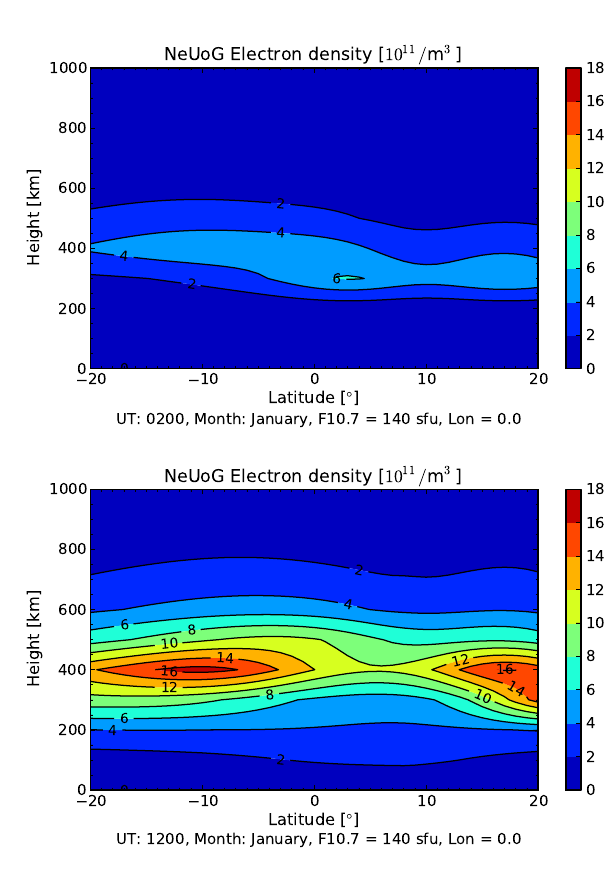
Fig. 2. Electron density distribution in January for F 10 . 7 = 140sfu as a function of latitude and height, at 0 ◦ longitude. The top panel shows the distribution at nighttime (02:00LT), the bottom panel shows the distribution at daytime (12:00LT), where the electron density reaches values of up to 18 . 0 × 10 11 electrons / m 3 . 24